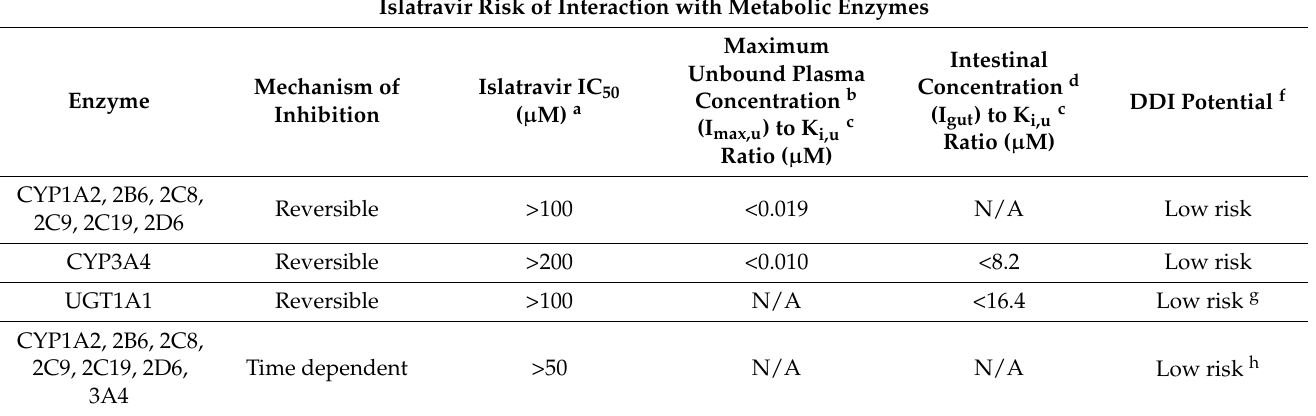
Table 2. Drug–drug interaction risk calculation for